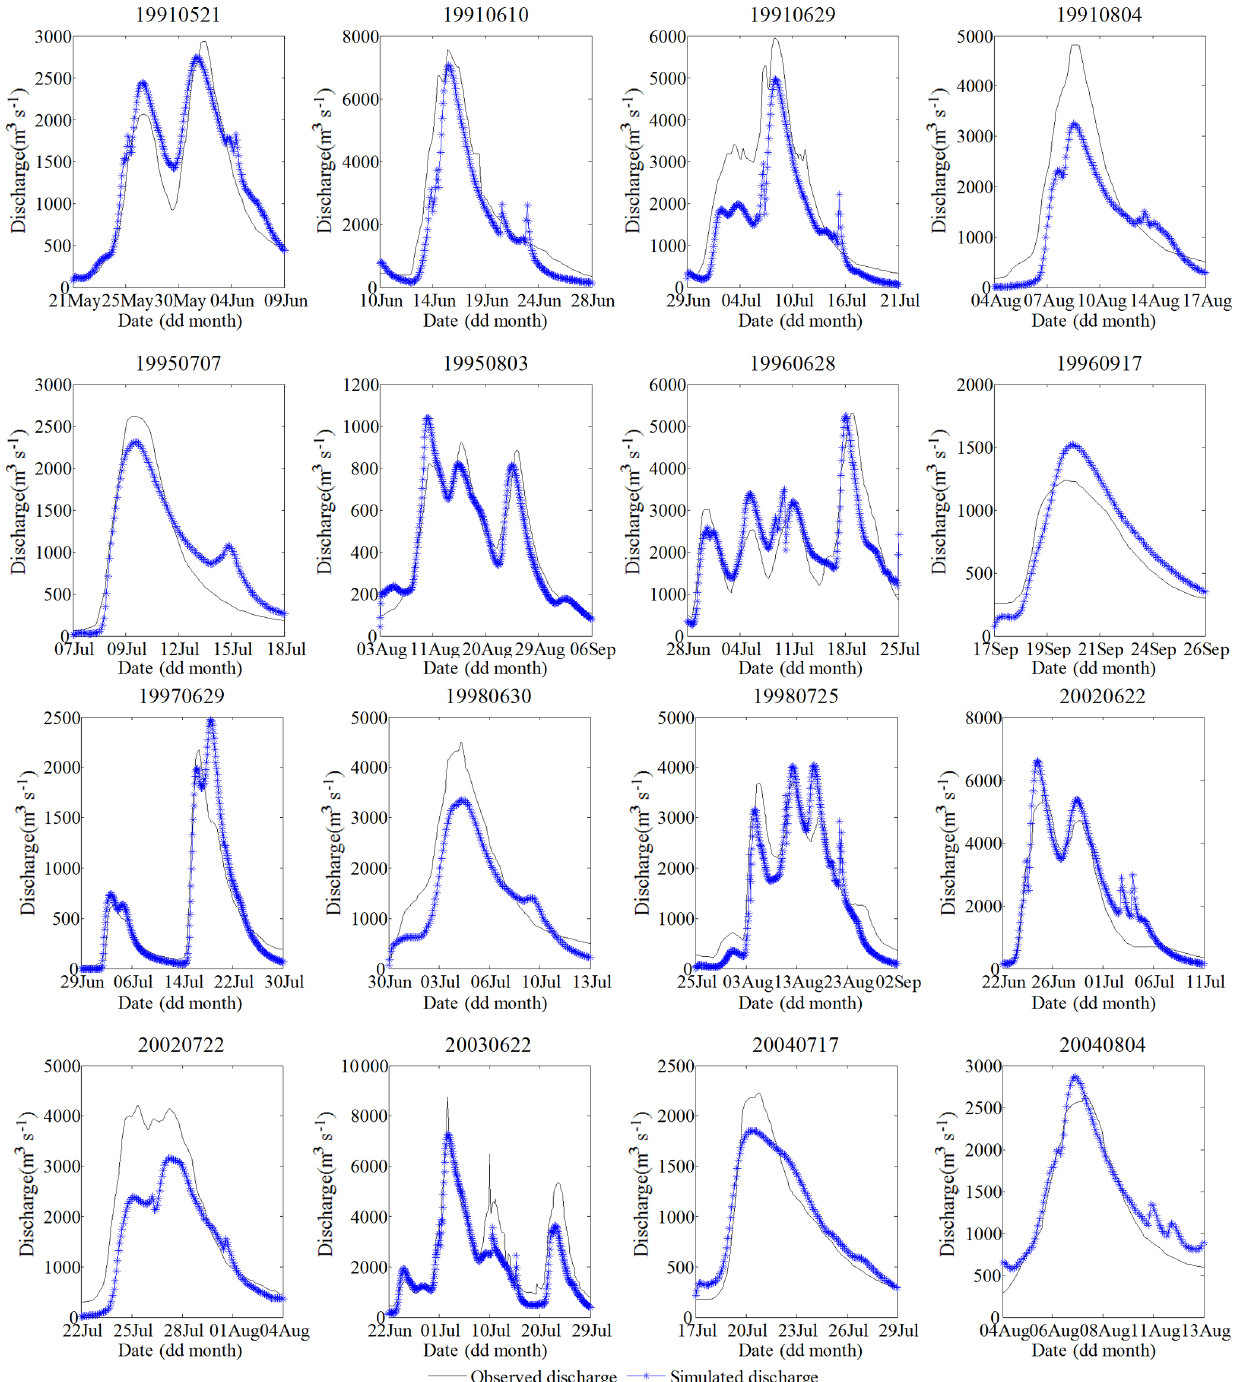
Figure 6. Comparisons between the observed and simulated sub-daily flood events for the calibration period at WJB.